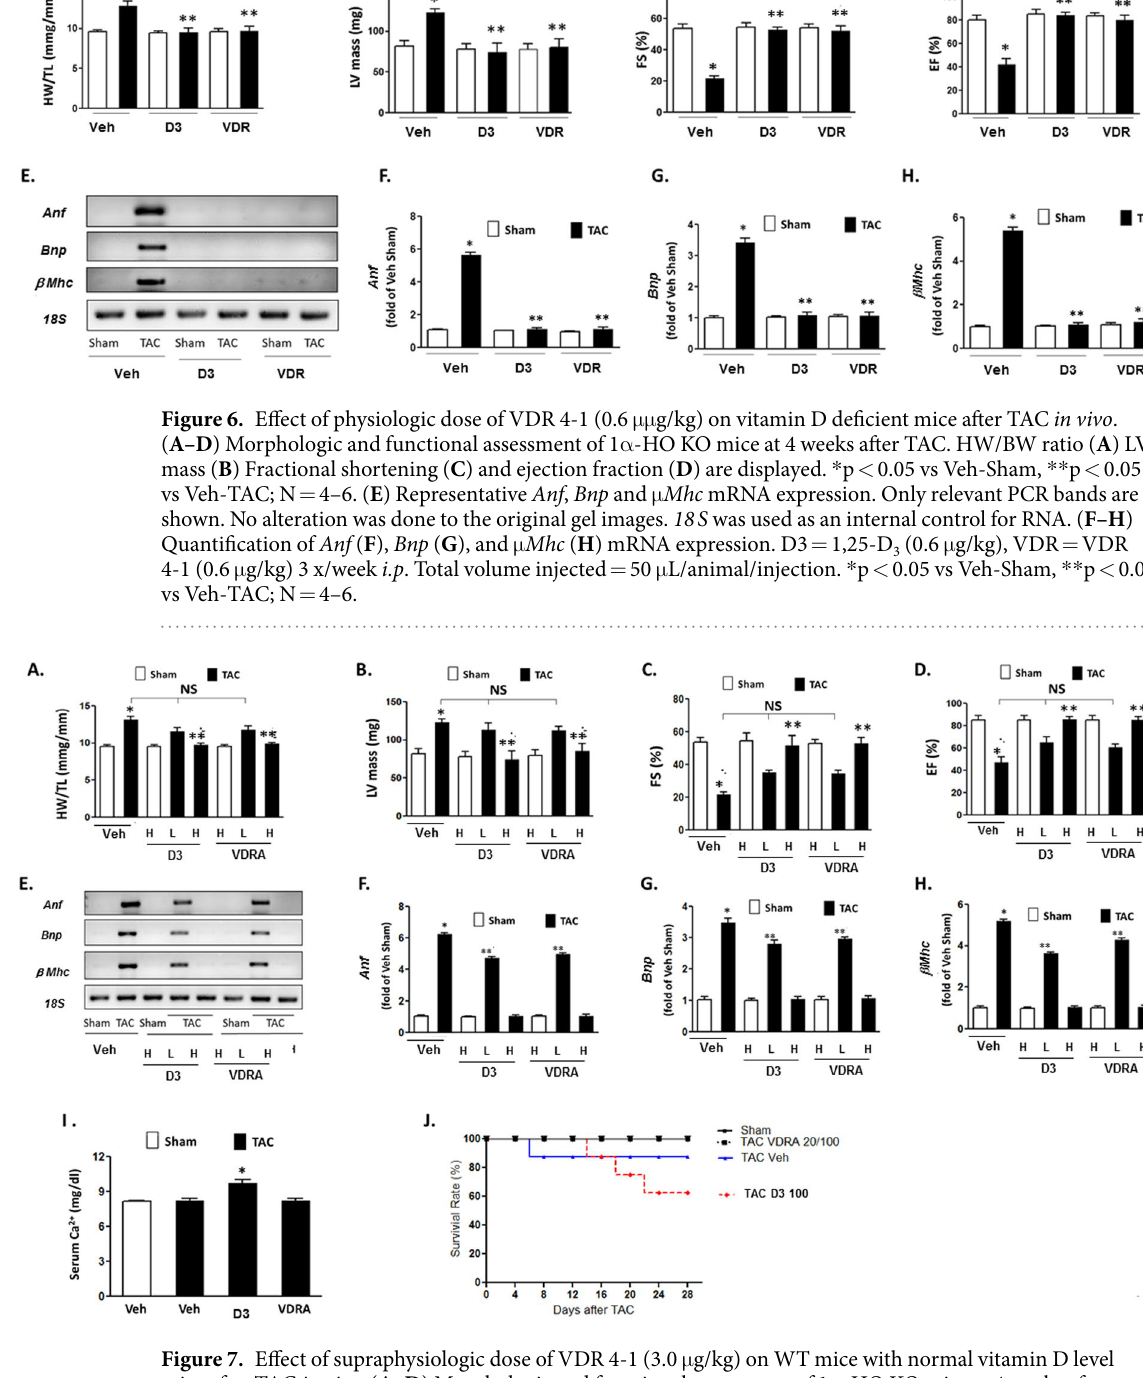
Figure 7. Effect of supraphysiologic dose of VDR 4-1 (3.0 μ g/kg) on WT mice with normal vitamin D level mice after TAC in vivo . ( A–D ) Morphologic and functional assessment of 1 α -HO KO mice at 4 weeks after TAC. HW/BW ratio ( A ), LV mass ( B ), Fractional shortening ( C ) and ejection fraction ( D ) are displayed. * p < 0.05 vs Veh-Sham, ** p < 0.05 vs Veh-TAC; N = 4–6. ( E ) Representative Anf , Bnp and μ Mhc mRNA expression. Only relevant PCR bands are shown. No alteration was done to the original gel images. 18 S was used as an internal control for RNA. ( F–H ) Quantification of Anf ( F ), Bnp ( G ), and μ Mhc ( H ) mRNA expression. * p < 0.05 vs Veh-Sham, ** p < 0.05 vs Veh-TAC; N = 4–6. ( I ) Serum Ca 2 + level after long-term injections D3 = 1,25-D 3 (3.0 μ g/kg), VDR = VDR 4-1 (3.0 μ g/kg) 3 x/week i.p . Total volume injected = 50 μ L/ animal/injection. * p < 0.05 vs Veh; N = 4–6. ( J ) Survival curve of mice after supraphysiologic dose of VDR